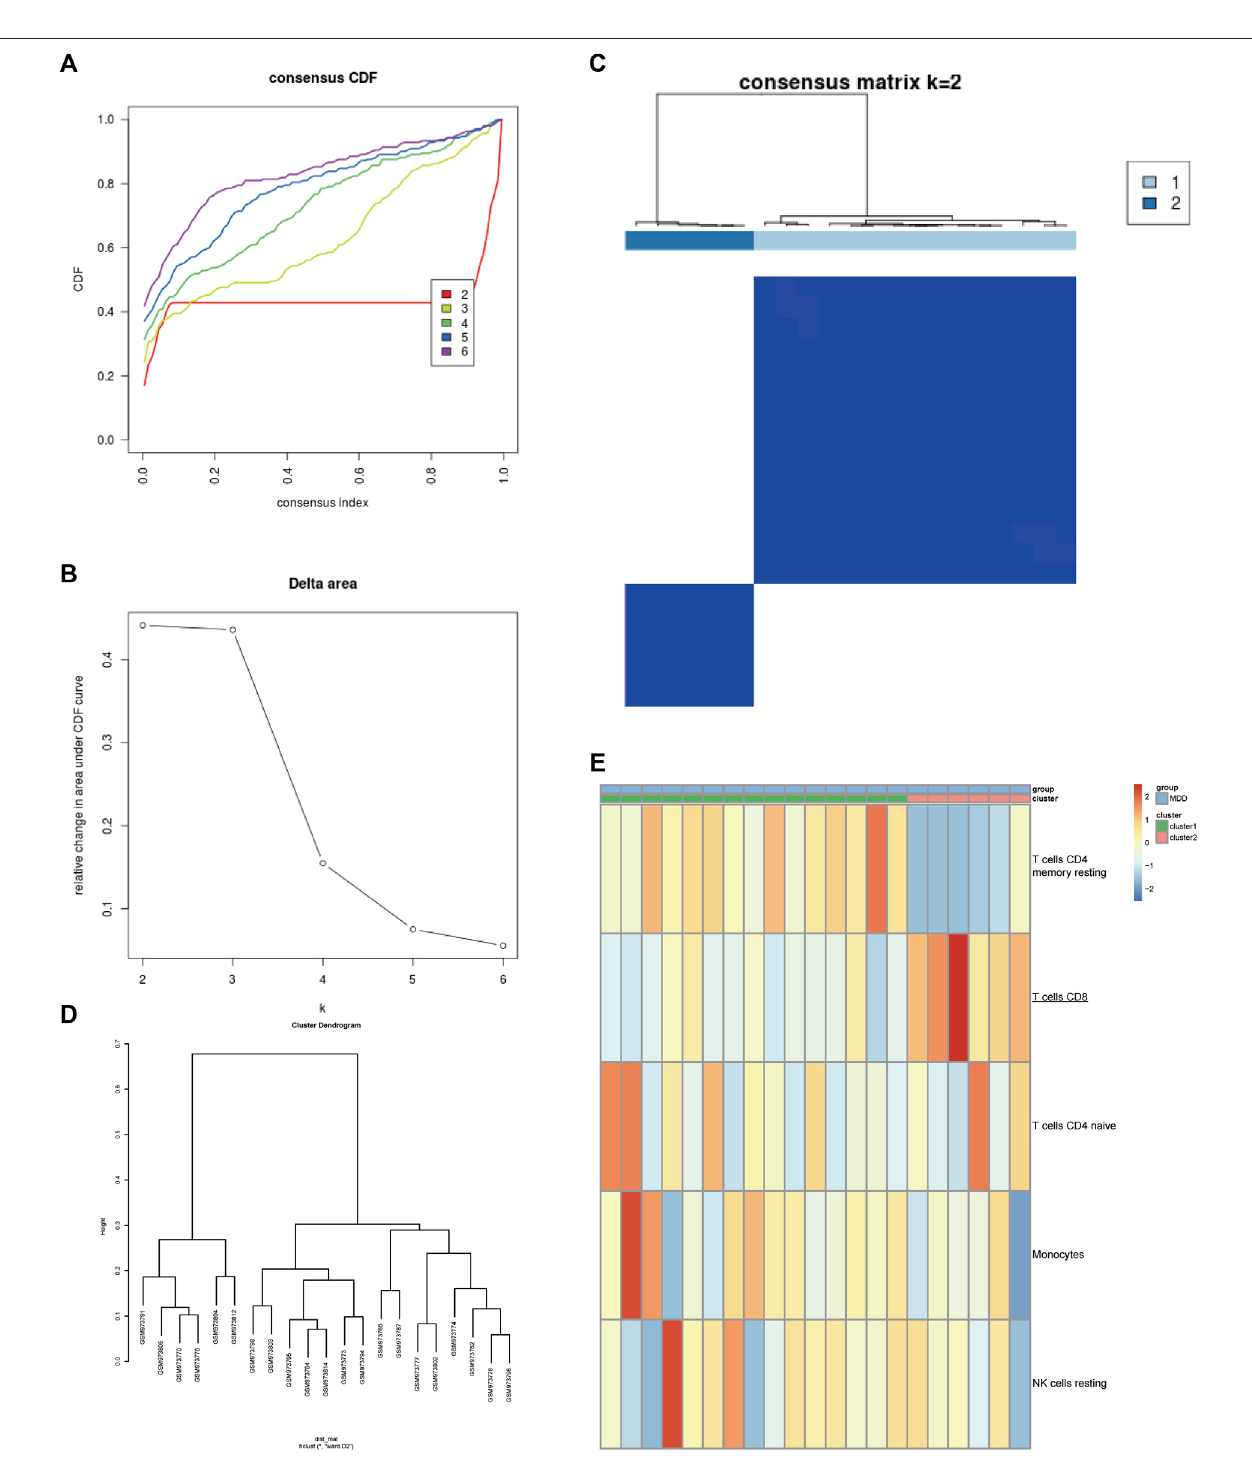
FIGURE3 | Validation ofthe clustering in theGSE39653 dataset. (A) Unsupervised clusteringwith the k-means algorithm ofentire samples. (B) Relative change in areaunderCDFcurvefork=2 – 6. (C) Theoptimalnumberofconsensusclustering. (D) Theclusterdendrogramamongallsamples. (E) ComparisonofIICproportionsof the top fi ve MAD (median absolute deviation) values among MDD clusters. Red indicates relative upregulation of gene expression; blue indicates the relative downregulation of gene expression; light yellow indicates no signi fi cant change in gene expression. MDD ( n = 21), major depressive disorder; IICs, in fi ltrated immune